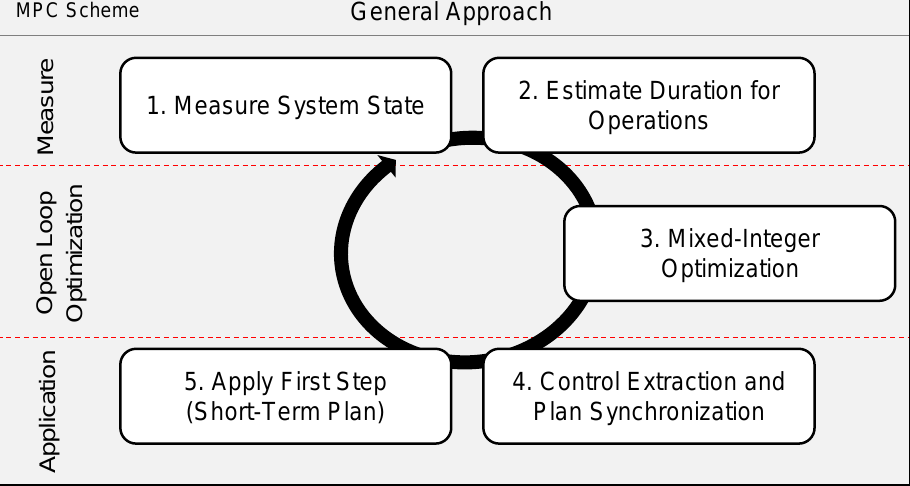
Figure 3. Steps of the proposed methodology and integration with the MPC